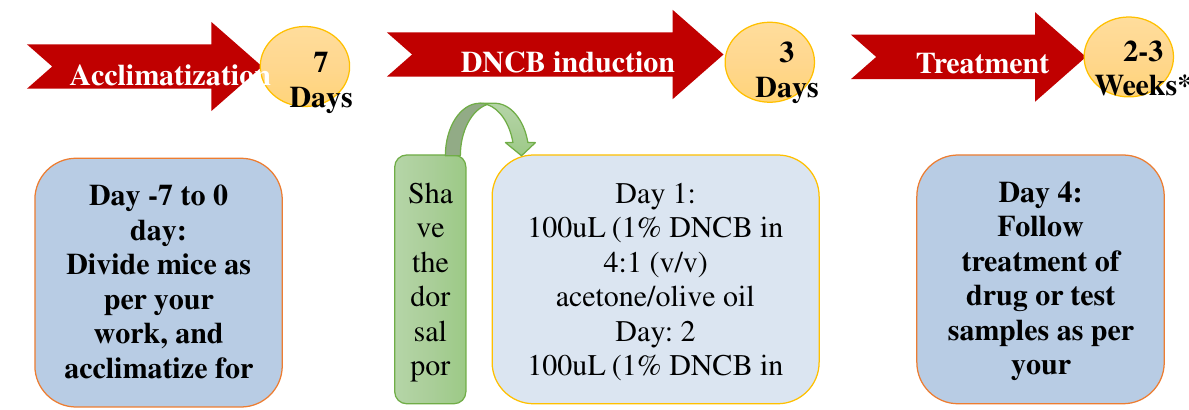
Figure 2: Flowchart of DNCB-induced atopic dermatitis in mice model